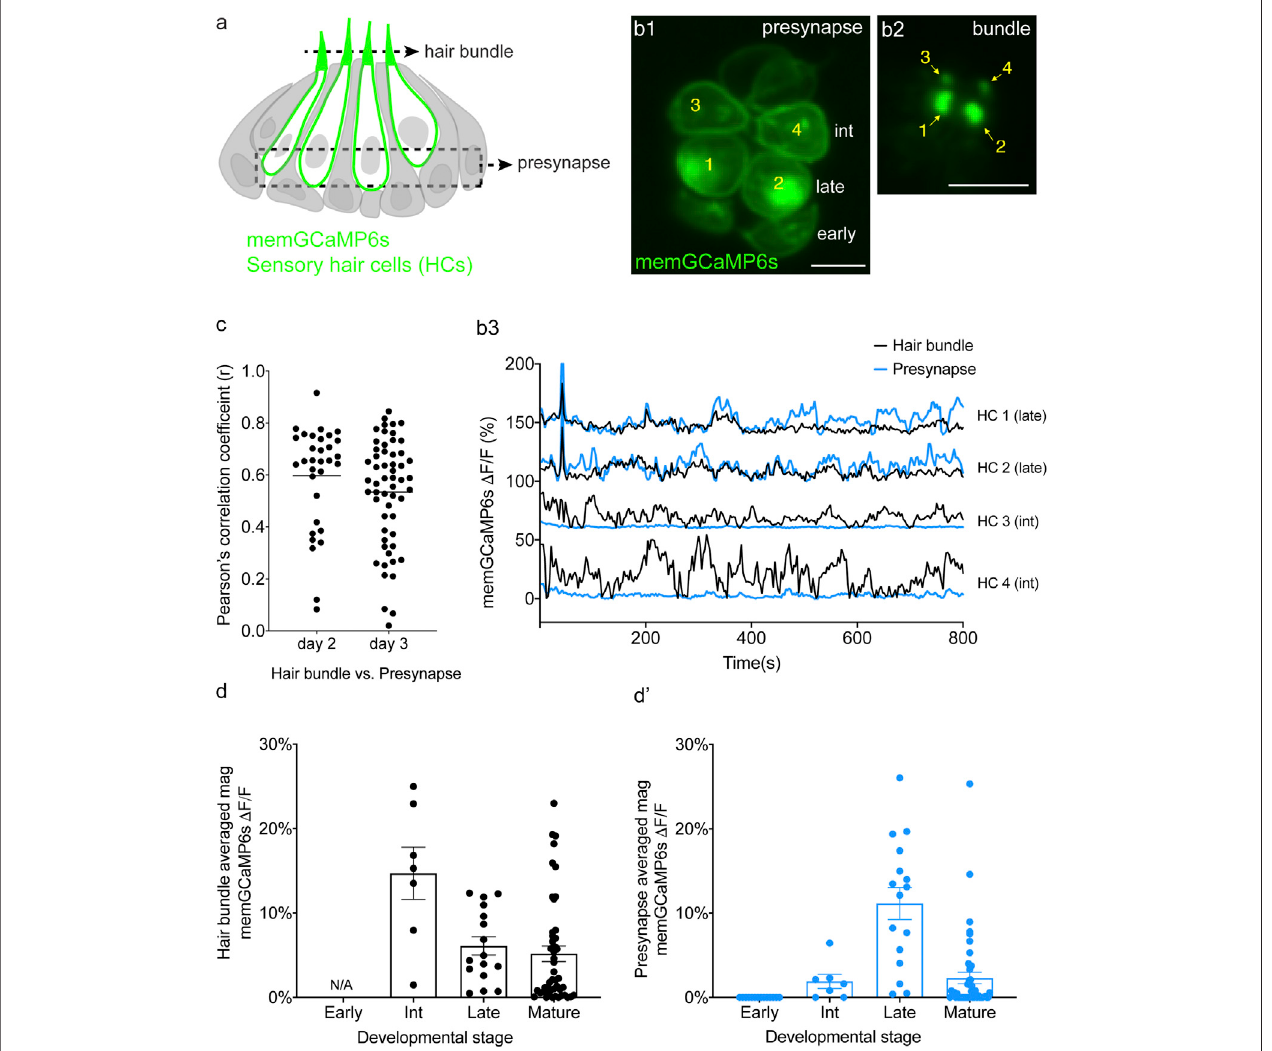
FIGURE 4 | Spontaneous calcium activity occurs in the mechanosensory bundle and at the presynapse. (A) Cartoon of a neuromast organ illustrating hair cells (green) expressing memGCaMP6s, surrounded by supporting cells (gray). (B1) Image of a representative neuromast showing the hair cell presynaptic region indicated by the dashed box in (A) taken from immature hair cells at day 2. Hair cells at three different developmental stages are labeled: early (no detectable hair bundle), intermediate (3, 4), and late (1, 2). (B2) An image of the hair bundles from the same cells as (B1) through the plane indicated by the dash line in (A) . (B3) Paired temporalcurvesofspontaneouscalciumactivityinhairbundles( B2 black)andthepresynapticregions( B1 blue)takenfromthesamehaircells. (C) Pearson ’ s R valuesof spontaneouscalciumactivitybetweenhairbundlesandthepresynapticregionsofthesamesetsofimmaturehaircells, n =32haircells( n =6neuromasts),day2and n = 56haircells( n =6neuromasts),day3. (D,E) Theaveragemagnitudeofspontaneouscalciumactivityinhairbundles (D) andpresynapticregion (E) inthesamesetofhair cellsduringtheprogressivestagesofdevelopment:early,intermediate,lateandmature.Noactivitycanbemeasuredinearlyhairbundles(N/A)asthebundlesarenotyet detectable. The spontaneous calcium activity in hair bundles peaks at the intermediate stage (D) and decreases upon maturation, while spontaneous calcium activity in the presynaptic regions peaks at the late stage (D 9 ) and decreases upon maturation. Scale bar = 5 μ m.